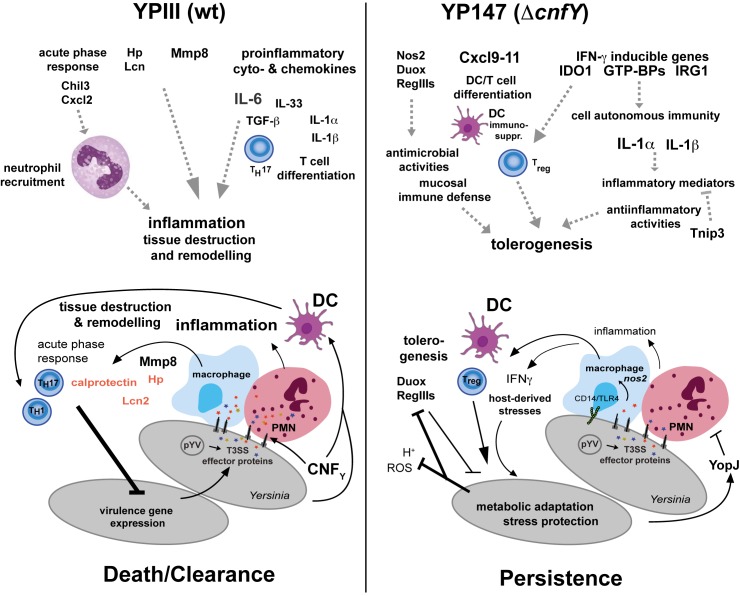
Model of CNFY influence on the development of Yersinia persistence.Schematic overview of induced inflammatory and acute phase responses, which are triggered by the Y. pseudotuberculosis strain YPIII and the isogenic CNFY-negative variant based on the transcriptome analysis of Yersinia-infected cecal tissue 5 dpi. Host responses that are expected to result from altered inflammatory responses and other defense reactions, are indicated by dashed arrows. Transcript-based adaptations of Y. pseudotuberculosis and the host during colonization of the cecum during acute and persistent infection and their influence on the outcome of the infection are illustrated.